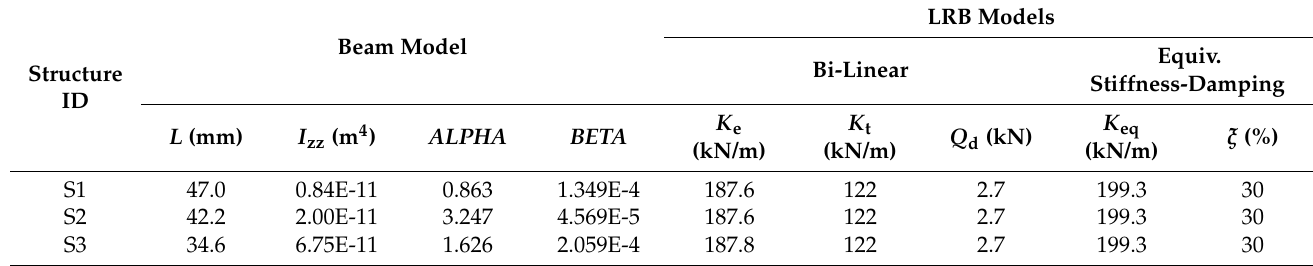
Table 5. Analysis input parameters for finite element Table 5. Analysis i nput parameters for finite element modeling.